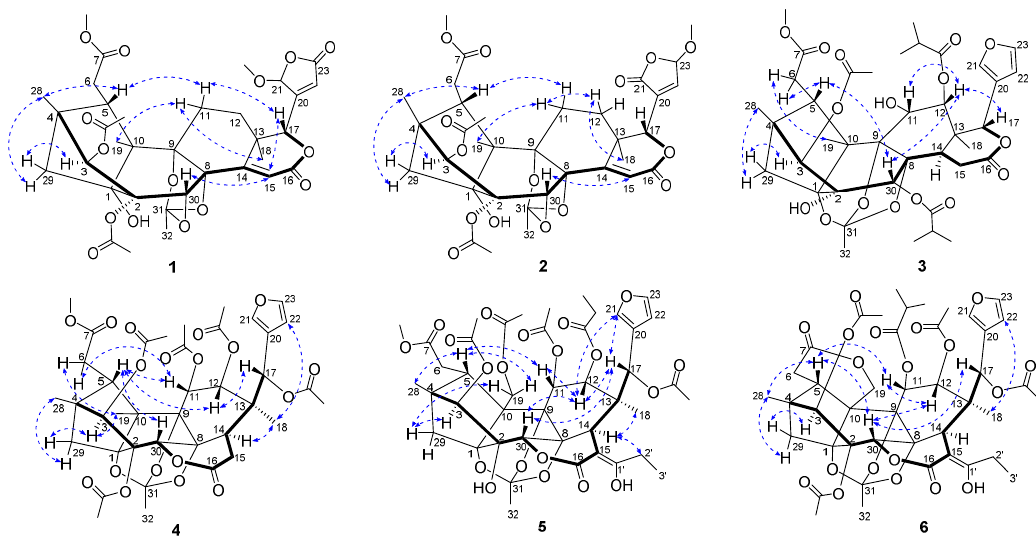
Figure 2. Key HMBC and 1 H- 1 H COSY correlations for compounds 1 – 6 .